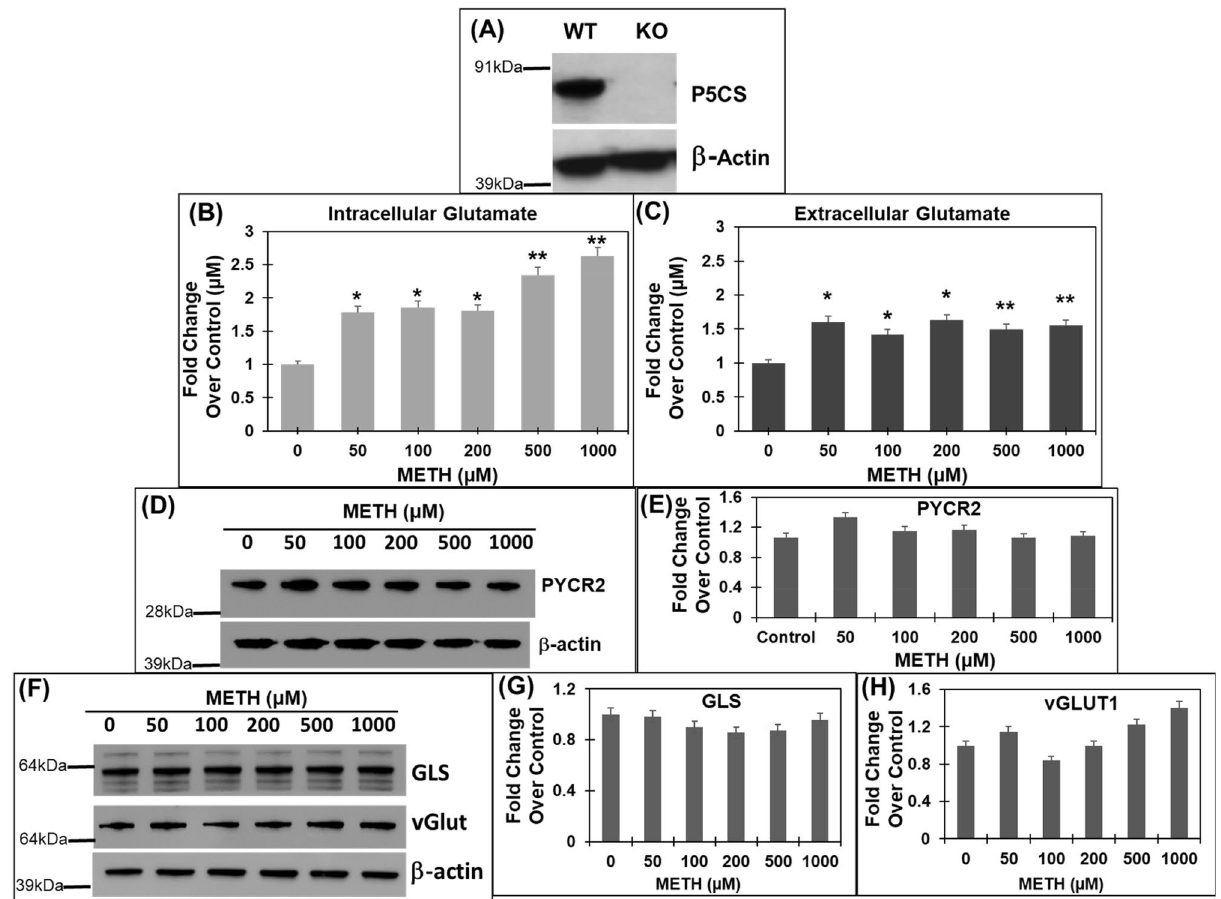
Figure 4. METH treatment of P5CS knockout ( P5CS -KO) SH-SY5Y cells significantly increases glutamate levels. The P5CS- KO SH-SY5Y cells were generated from wild-type SH-SY5Y cells using CRISPR/Cas9 system. Following which the P5CS -KO cells were treated with METH for 24 h and cellular lysates and cell-free supernatants were collected. ( A ) Western blot showing a lack of P5CS expression in P5CS -KO vs. WT SH-SY5Y cells (n = 3). β-actin was used as a loading control. ( B , C ) Effect of METH on glutamate in P5CS -KO cells. ( B ) The cell extracts were used to measure intracellular glutamate while ( C ) the cell-free supernatants were used to measure extracellular glutamate (n = 3). A marked increase in levels of both intracellular and extracellular glutamate was obtained in P5CS -KO cells after METH treatment. ( D,E ) Effect of acute METH treatment on PYCR2 in P5CS -KO cells. Representative western blot of PYCR2 in ( D ) following acute METH treatment (n = 3). β-actin was used as a loading control. ( E ) Densitometric analyses of PYCR2 normalized to β-actin. ( F – H ) Effect of acute METH treatment on GLS and vGlut1 in P5CS -KO cells. ( F ) Representative western blot of GLS and vGLUT1 in METH-treated P5CS -KO SH-SY5Y cells (n = 3). β-actin was used as a loading control. ( G , H ) Densitometric analyses of GLS and vGLUT1 western blot normalized to β-actin. Data are presented as the mean ± SEM of at least three independent experiments. *p < 0.05, **p < 0.005 represents statistical comparison of untreated vs METH-treated